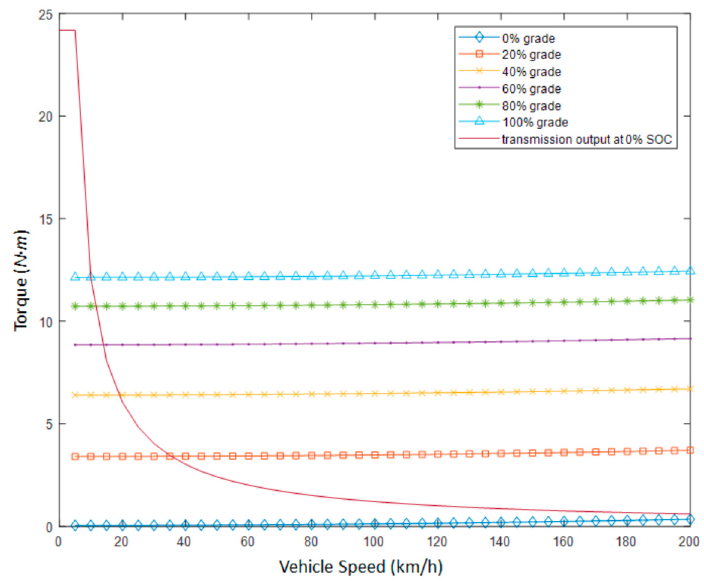
Figure 15. Target vehicle load torque profile with PS-FHV output at 0% SOC status.